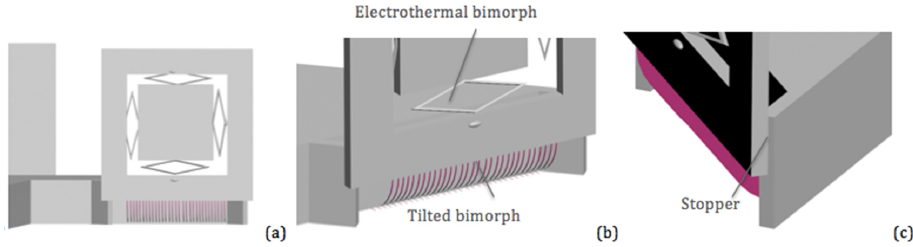
Figure 6. Schematic view of the mirror’s tilting structure. ( a ) 2D MEMS mirror design. ( b ) A side view of the mirror’s tilting structure. ( c ) A closer view of the mirror’s tilting structure with the stoppers.